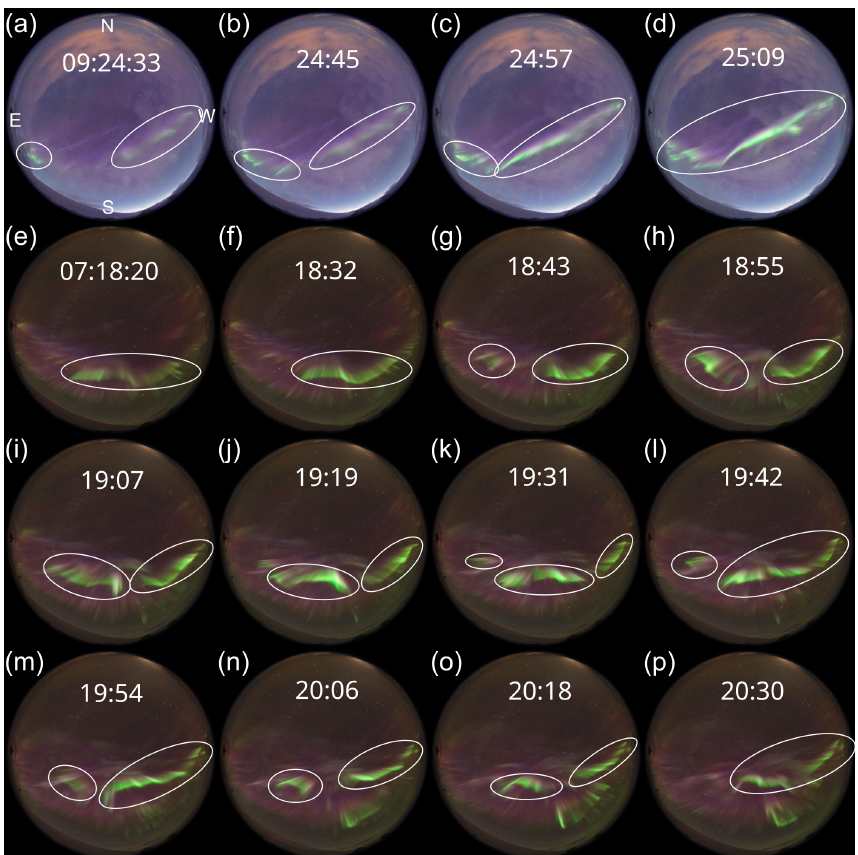
Figure 3. Merging of auroral patches preceding the appearance of a PMAF. Two series of ASC images showing large-scale auroral patches marked by white ellipses merging into arc-shaped PMAFs. The images were taken in the same manner and have the same orientation as in Fig. 2. The cadence of this image series is approximately 12s, with image (a) being taken at 09:24:33UTC and image (e) being taken at 07:18:20UTC on 18 December 2017. The appropriate time of each following image is printed in the [mm:ss]